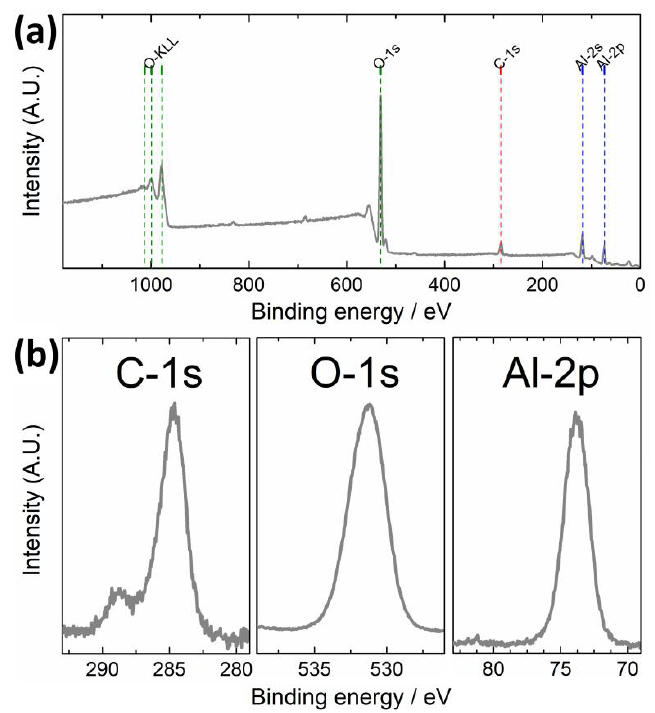
Figure 8. XPS analysis of Al 2 O 3 /CuO-3D heterostructures indicates the presence of C, O and Al. The respective peak positions are indicated by dashed lines in the survey spectrum ( a ). In the resolution spectra ( b ), of the C-1s, O-1s and Al-2p